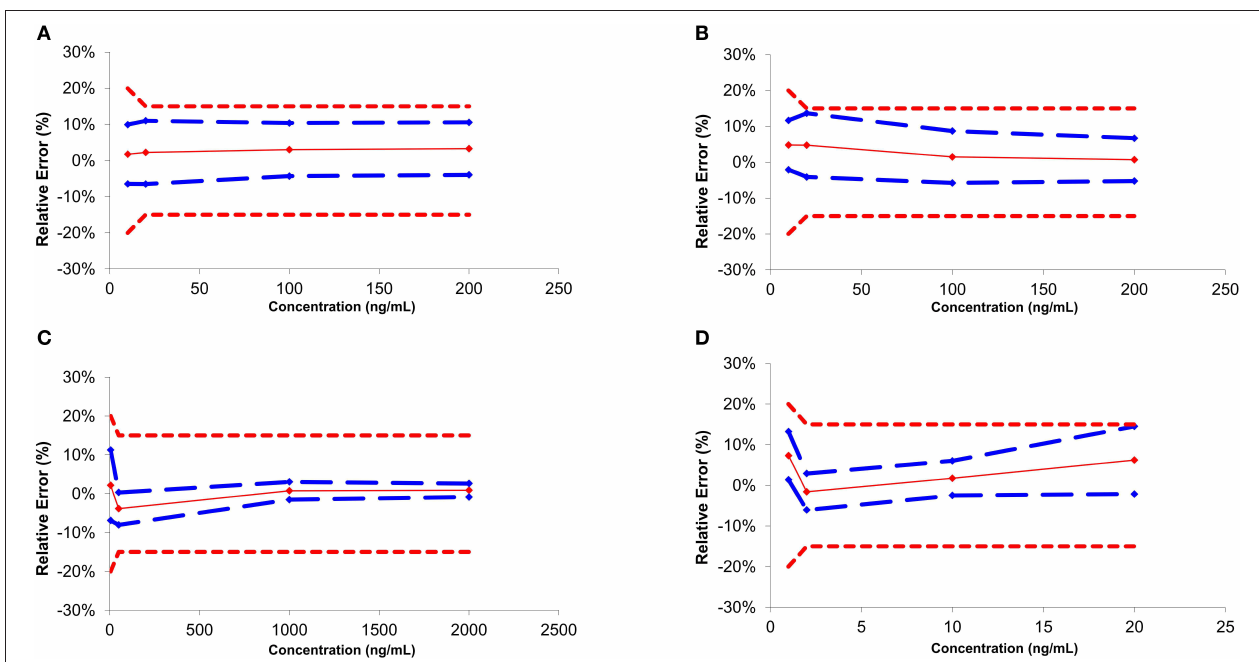
FIGURE 2 | Accuracy profile for the main classes of drugs of abuse regulated by FEDRO [Cocaine (A) , Amphetamine (B) , Morphine (C) , and THC (D) ].